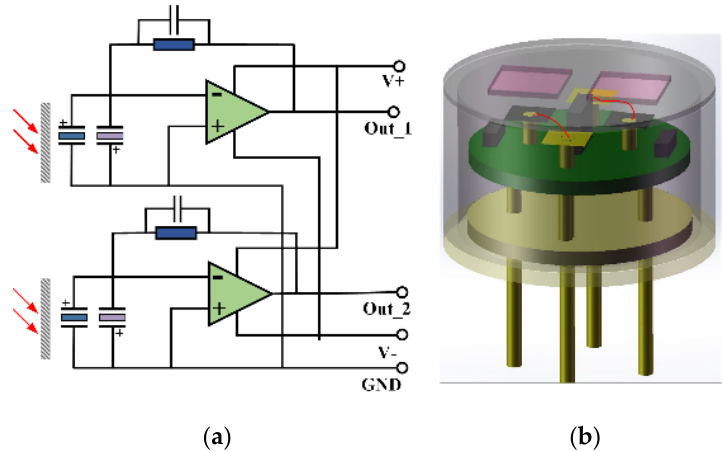
Figure 1. ( a ) Principal diagram of the sensor. ( b ) 3D schematic diagram.